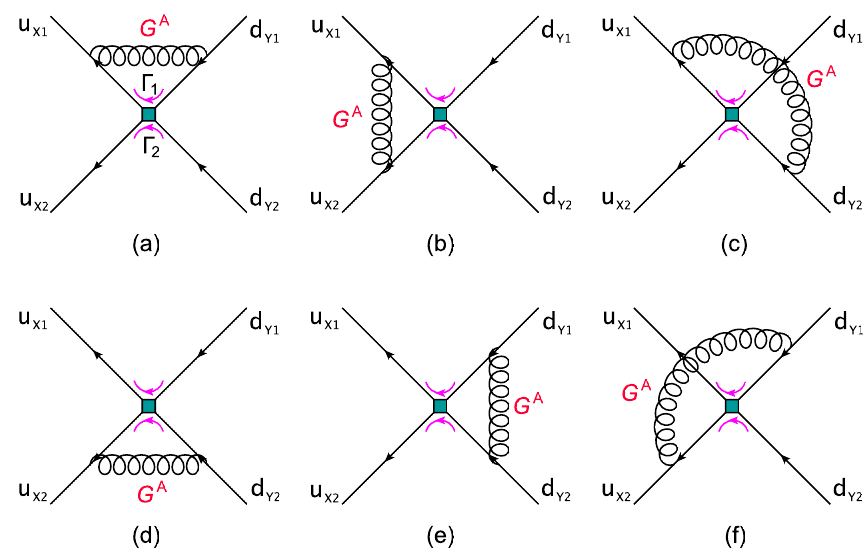
Figure 2 . One-loop QCD corrections to the four-quark operators ( u X